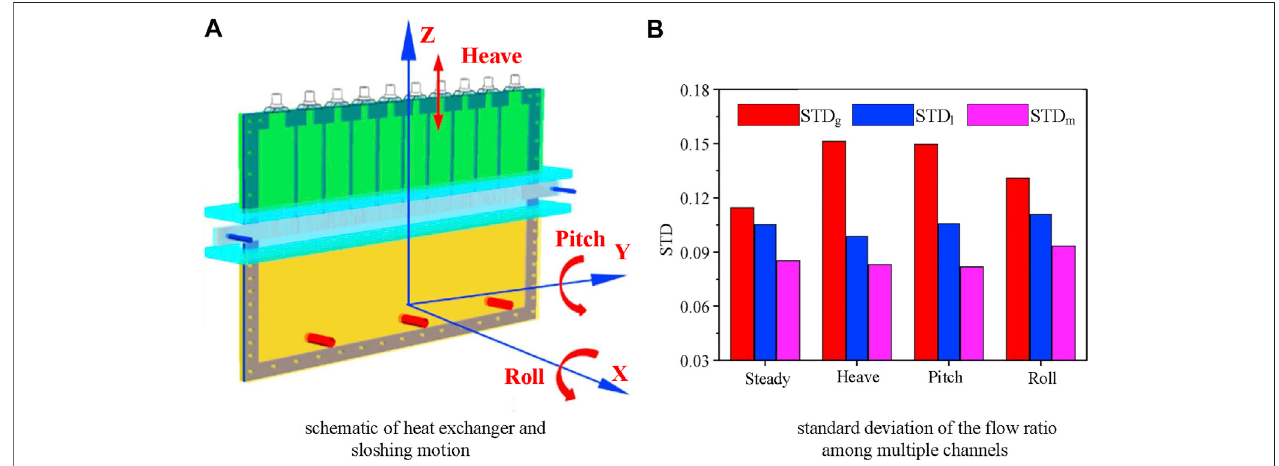
FIGURE 10 | Distribution of working fl uids among multiple channels (Zheng et al., 2019). (A) Schematic of the heat exchanger and sloshing motion. (B) Standard deviation of the fl ow ratio among multiple channels.